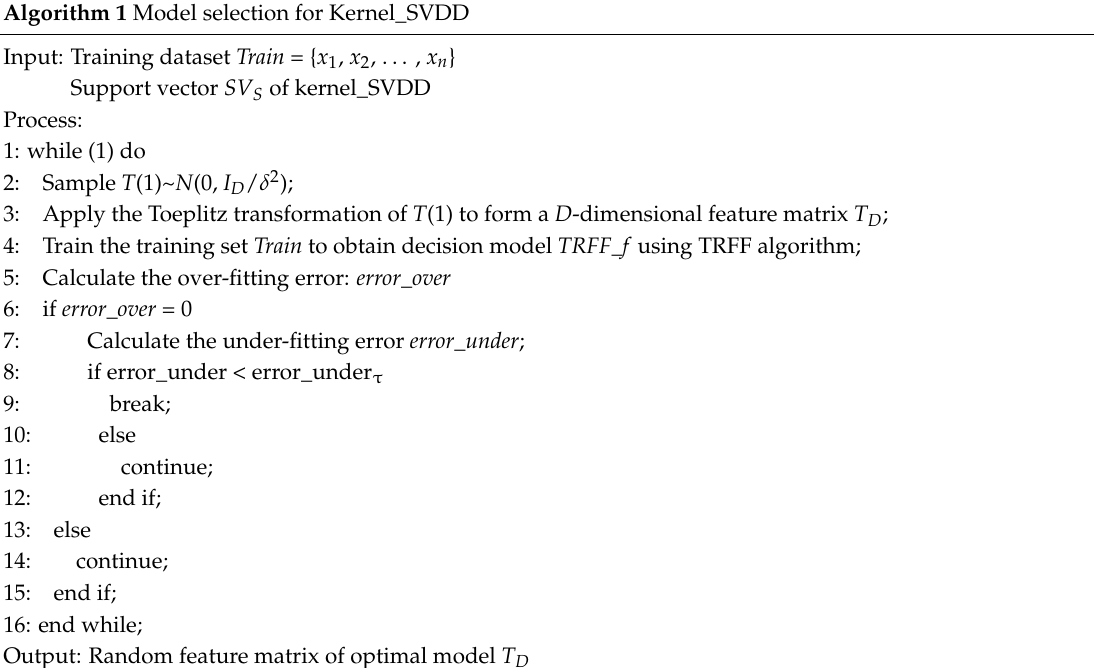
Algorithm 1 Model selection for Kernel_SVDD